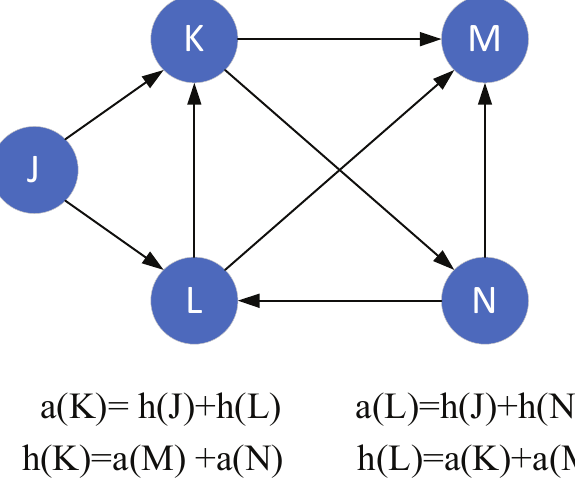
Figure 1. A simple example of calculating hub and authority